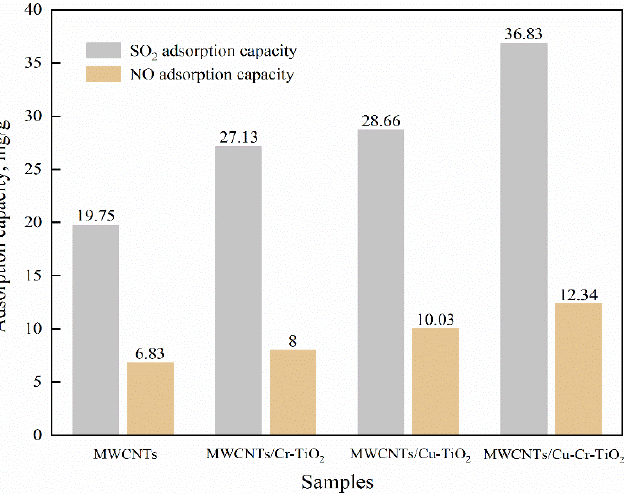
Figure 7. Performance comparison of desulfurization and denitrification on different adsorbents. The improvement of simultaneous desulfurization and denitrification performance